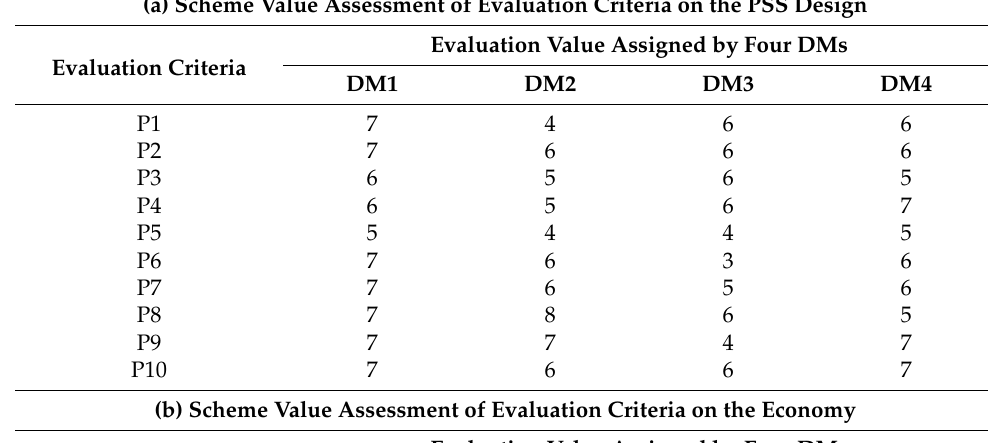
Table A3. Initial evaluation matrix of the electric forklift PSS concept (taking the CS3 as an example). (a) Scheme Value Assessment of Evaluation Criteria on the PSS Design Evaluation Criteria